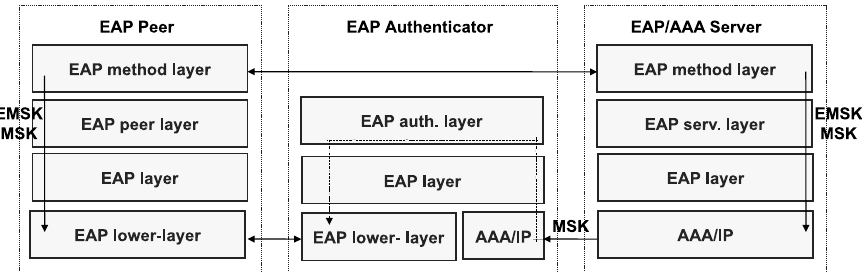
Figure 2. Extensible Authentication Protocol (EAP) pass-through authentication